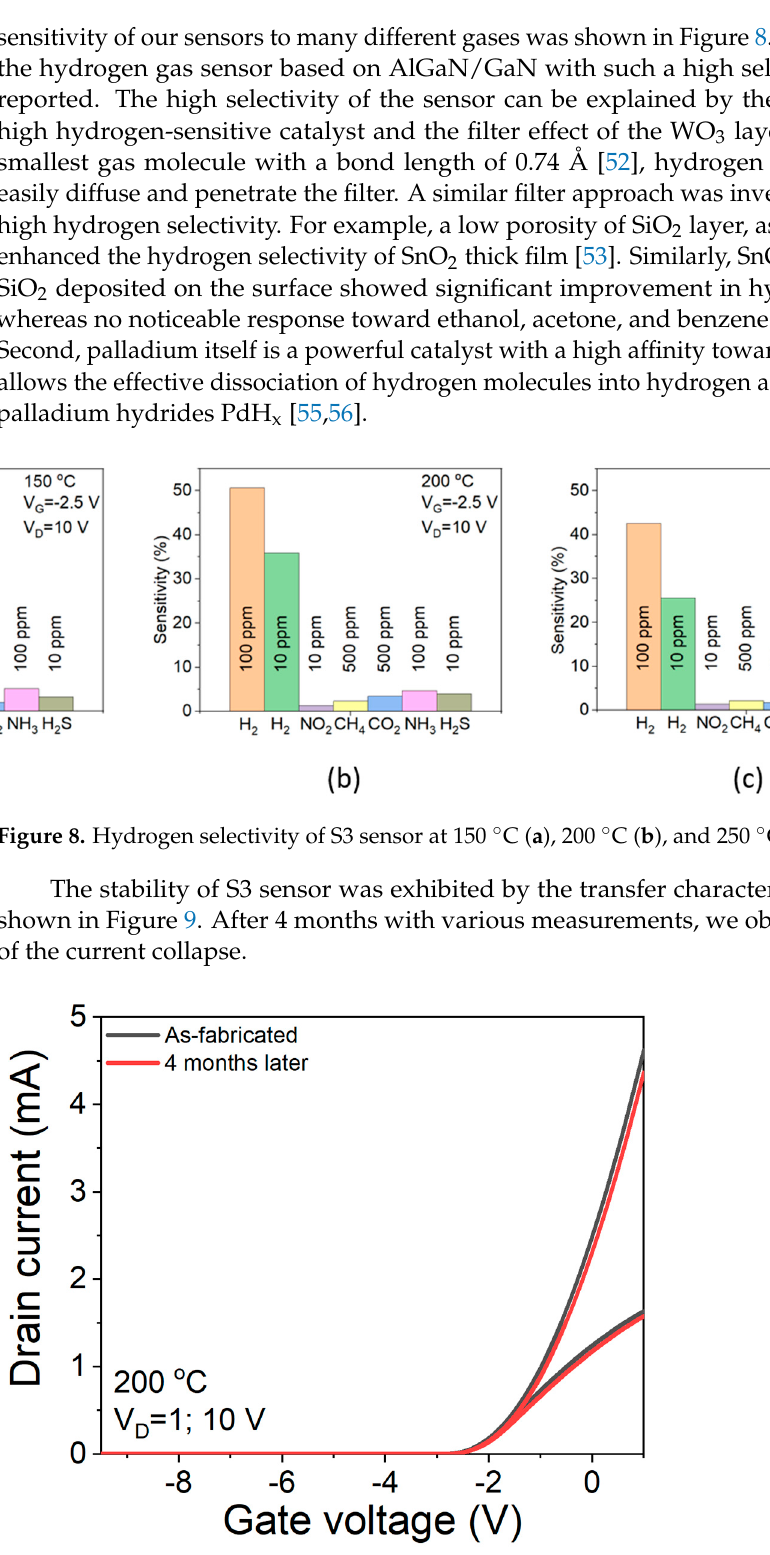
Figure 9. Stability of S3 sensor.